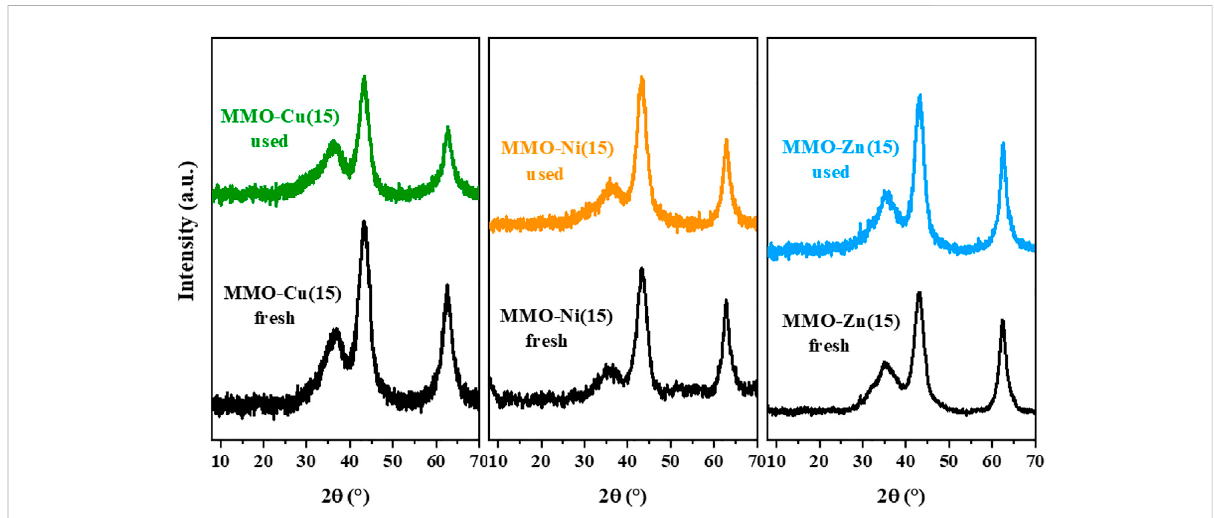
FIGURE 9 XRD of the fresh and used mixed oxides in the transesteri fi cation